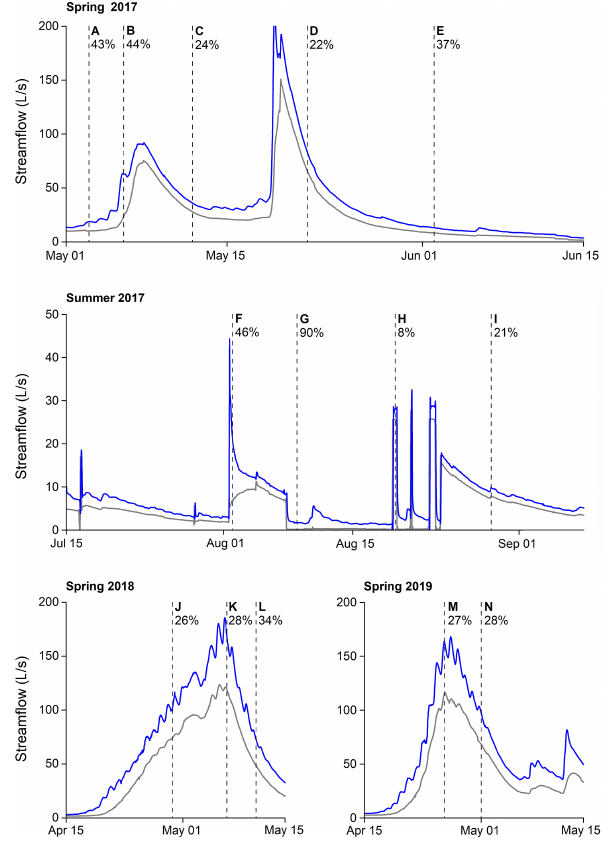
Figure 2. Hydrographs of the gauging stations C5 (grey) and C6 (blue) during the study period (spring 2017, summer 2017, spring 2018 and spring 2019). The vertical dashed lines and letters correspond to the 14 sampling campaigns. The percentages indicate the net gain in streamflow between the gauging stations C5 and